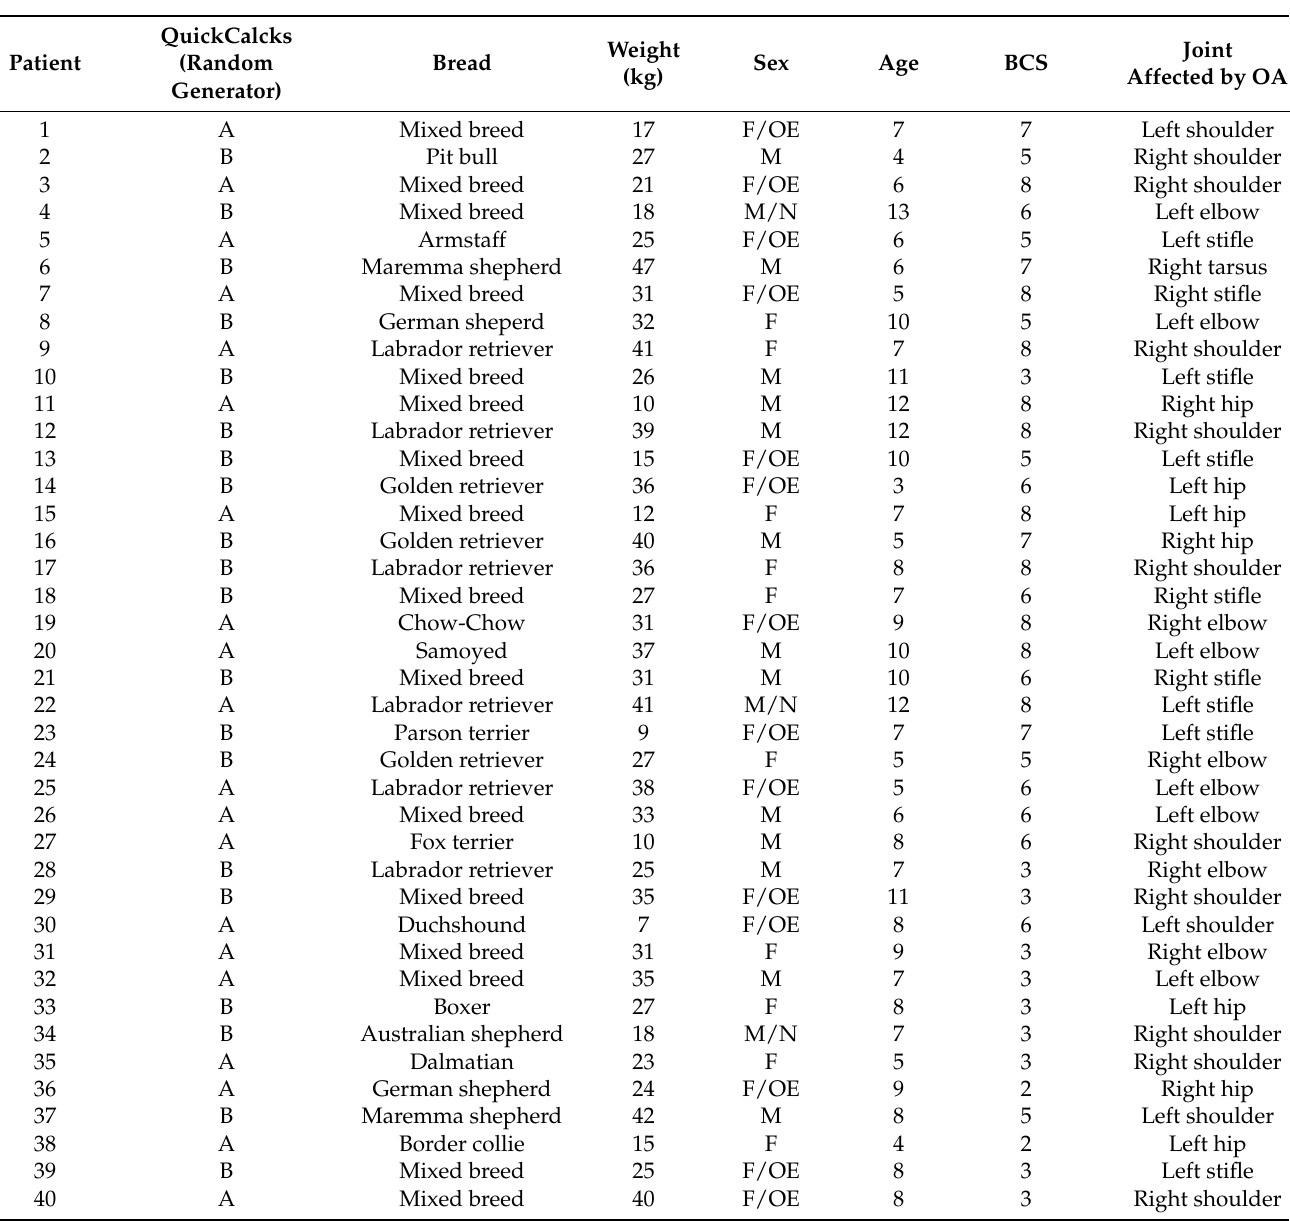
Table 5. List of enrolled patients; complete signalment data and randomization. (F = female; M